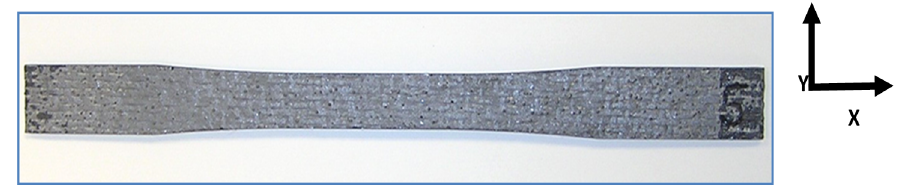
Figure 5. Optical photograph of an environmental barrier coating (EBC) coated melt infiltrated silicon carbide fiber reinforced silicon carbide matrix composite (MI SiC/SiC) composite dog bone specimen.